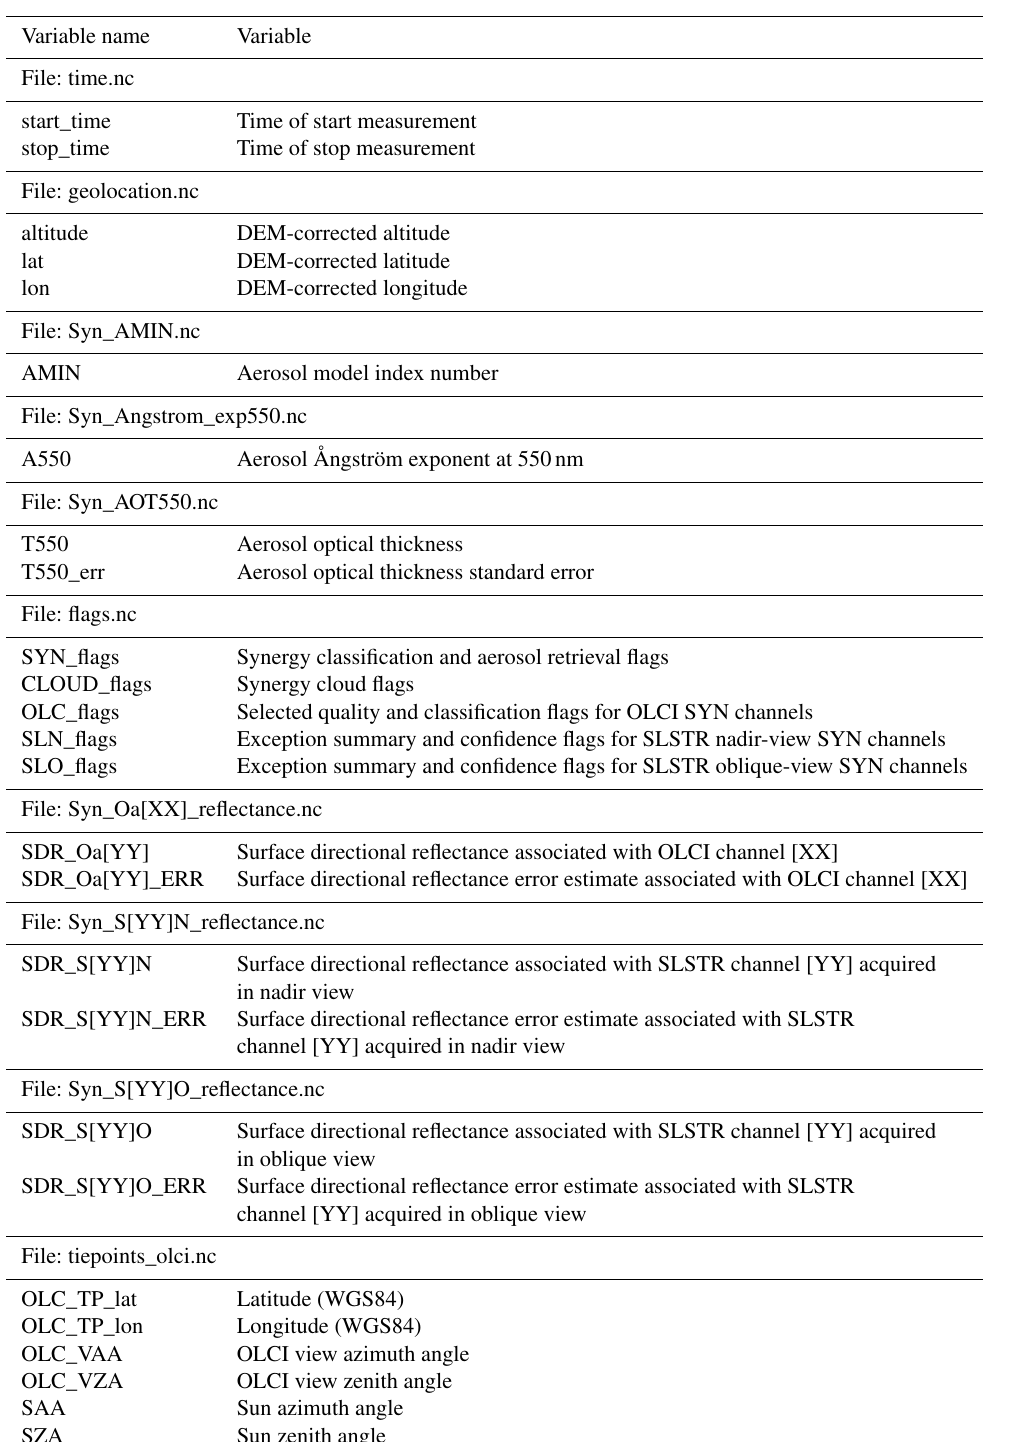
Table A3. Sentinel-3 SY_2_SYN files and variables